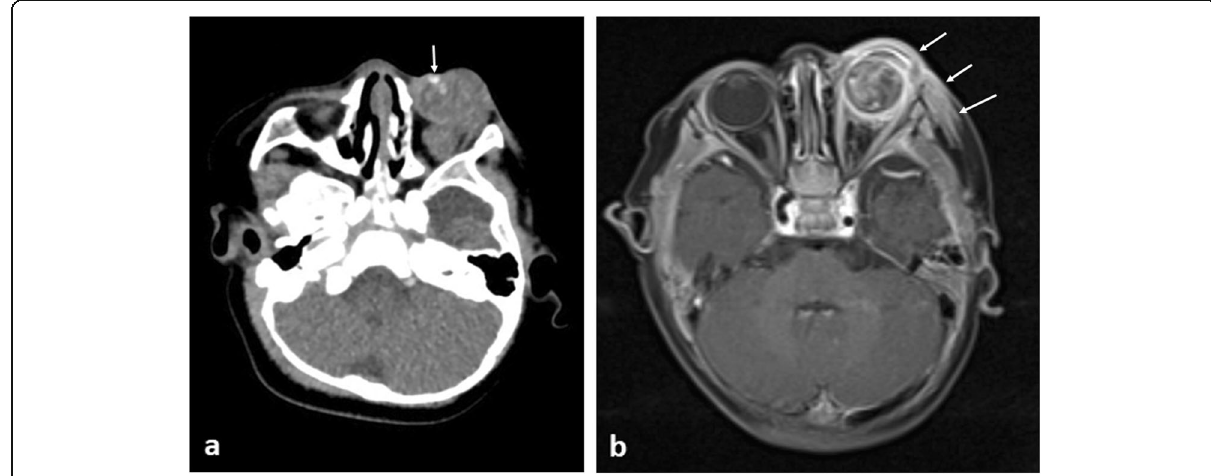
Fig. 5 A 6-month-old male with biopsy proven intraocular rhabdoid tumour. a Axial CT showing a large left intraorbital mass involving mainly the intraconal compartment with associated marked proptosis. The lesion demonstrates internal calcifications (arrow). b Post-contrast fat- saturated T1-weighted MR image shows intra and periorbital abnormal contrast enhancement (arrows)